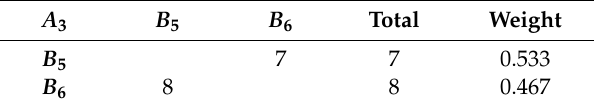
Table A10. Judgment matrix of B 5 – B 6 .